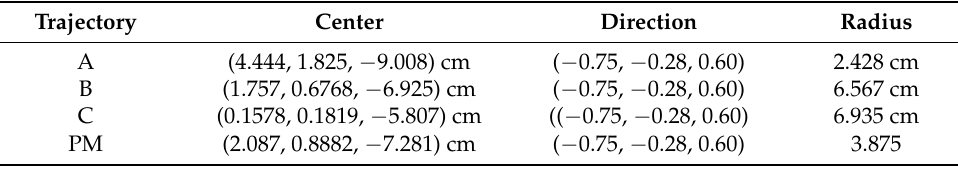
Table 7. ST axis circle fitting.